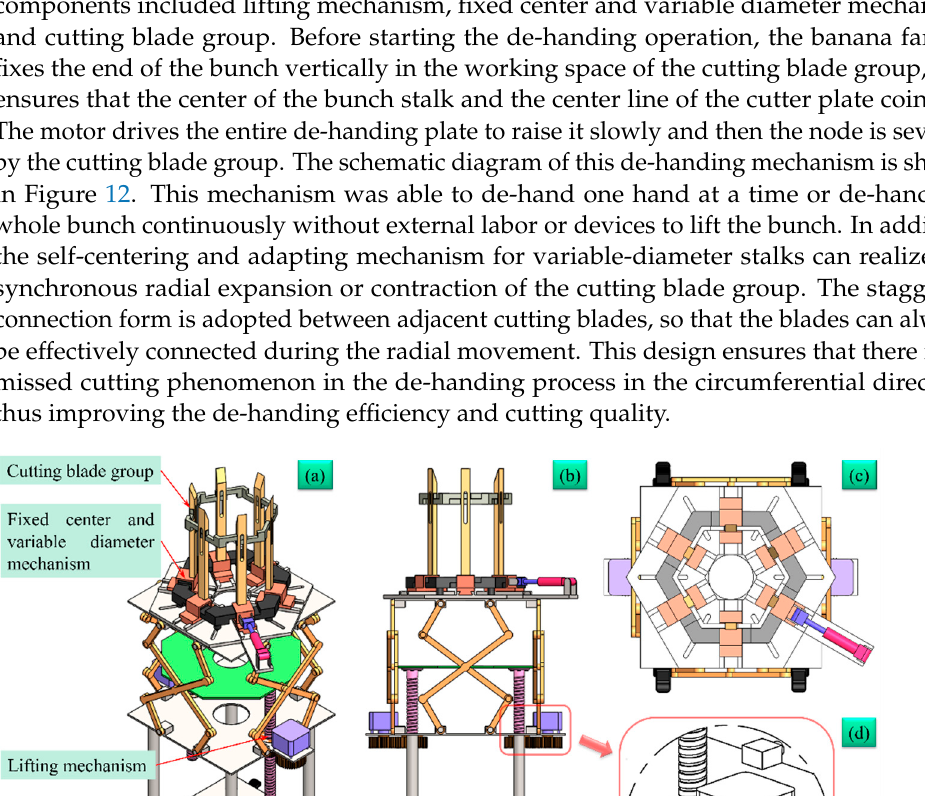
Figure 11. De ‐ handing machine based on iris ‐ gear ‐ like mechanism. ( a ) Schematic diagram of the structure of de ‐ handing machine, ( b ) Axonometric view of de ‐ handing mechanism, ( c ) Top view of de ‐ handing mechanism, ( d ) 3D model of arc blade.